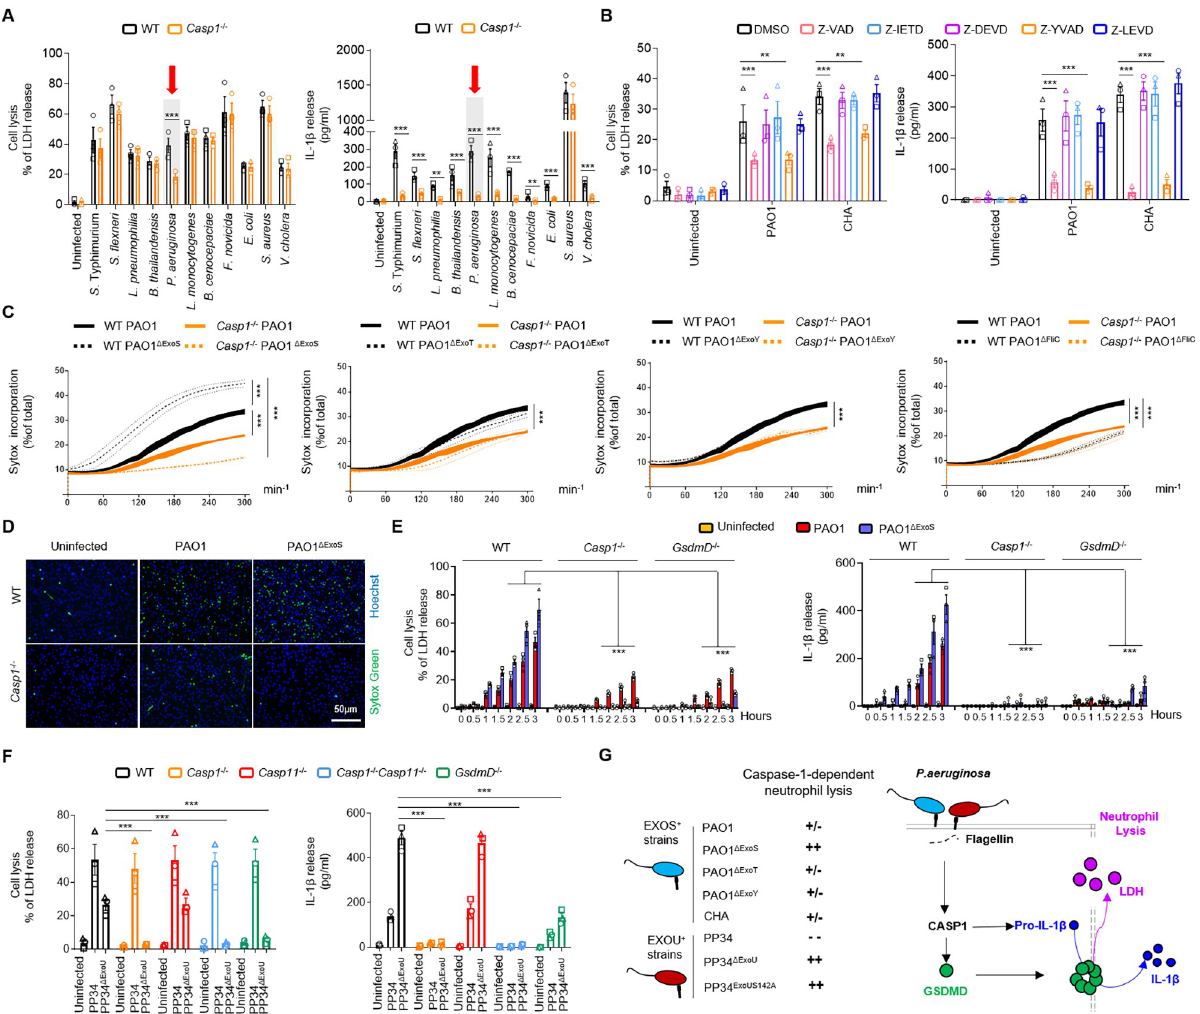
Fig 1. Various Pseudomonas aeruginosa strains trigger Caspase-1-dependent and -independent neutrophil lysis. A. Measure of cell lysis (release of LDH) and IL-1 β release in WT or Casp1 -/- murine Bone Marrow Neutrophils (BMNs) infected for 3 hours with various bacteria at a multiplicity of infection (MOI) of 10. �� p � 0.01 ��� p � 0.001, Two-Way Anova with multiple comparisons. Values are expressed as mean ± SEM. Graphs show combined values from three independent experiments. B. Measure of cell lysis (release of LDH) and IL-1 β release in human blood neutrophils infected for 3 hours with Pseudomonas aeruginosa strains PAO1 or CHA (MOI 5) in presence/absence of various Caspase inhibitors, Z-VAD (pan Caspase, 20 μ M), Z-YVAD (Casp1 inhibitor, 40 μ M), Z-DEVD (Casp3 inhibitor, 40 μ M), Z-IETD (Casp8 inhibitor, 40 μ M) or Z-LEVD (Casp4/5 inhibitor, 40 μ M). �� p � 0.01 ��� p � 0.001, Two-Way Anova with multiple comparisons. Values are expressed as mean ± SEM. Graphs show values from three independent experiments with one different donor each time. C, D. Measure of plasma membrane permeabilization and associated fluorescent microscopy images over time using SYTOX Green incorporation in WT or Casp1 -/- BMNs infected with Pseudomonas aeruginosa PAO1 or various isogenic mutants lacking Flagellin (FliC, PAO1 Δ FliC ) or T3SS-derived toxins ExoS, ExoY, ExoT (PAO1 Δ ExoS , PAO1 Δ ExoY , PAO1 Δ ExoT ). ��� p � 0.001, Two-Way Anova with multiple comparisons. Values are expressed as mean ± SEM. Graphs show combined values from three independent experiments. Hoechst (Blue, DNA), Sytox Green (DNA from neutrophils with permeabilized membranes, Green). Scale Bar: 50 μ m . E. Measure of cell lysis (release of LDH) and IL-1 β release in WT, Casp1 -/- and GsdmD -/- murine Bone Marrow Neutrophils (BMNs) infected for the indicated times with PAO1 or its isogenic mutant PAO1 Δ ExoS at an MOI of 10. ��� p � 0.001, Two-Way Anova with multiple comparisons. Values are expressed as mean ± SEM. Graphs show combined values from three independent experiments. F. Measure of cell lysis (release of LDH) and IL-1 β release in WT, Casp1 -/- , Casp11 -/- , Casp1 -/- Casp11 -/- and GsdmD -/- murine Bone Marrow Neutrophils (BMNs) infected for 3 hours with Pseudomonas aeruginosa PP34 strain or its isogenic mutant PP34 Δ ExoU at a multiplicity of infection (MOI) of 2. ��� p � 0.001, Two-Way Anova with multiple comparisons. Values are expressed as mean ± SEM. Graphs show combined values from three independent experiments. G. Overview of the importance of Caspase-1 at driving neutrophil pyroptosis in response to various Pseudomonas aeruginosa strains.